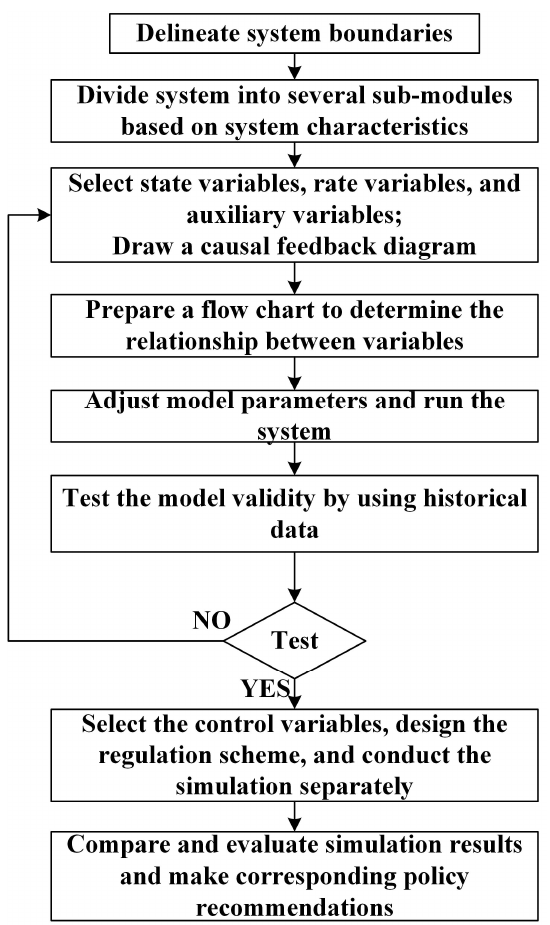
Figure 2. SD flow chart.